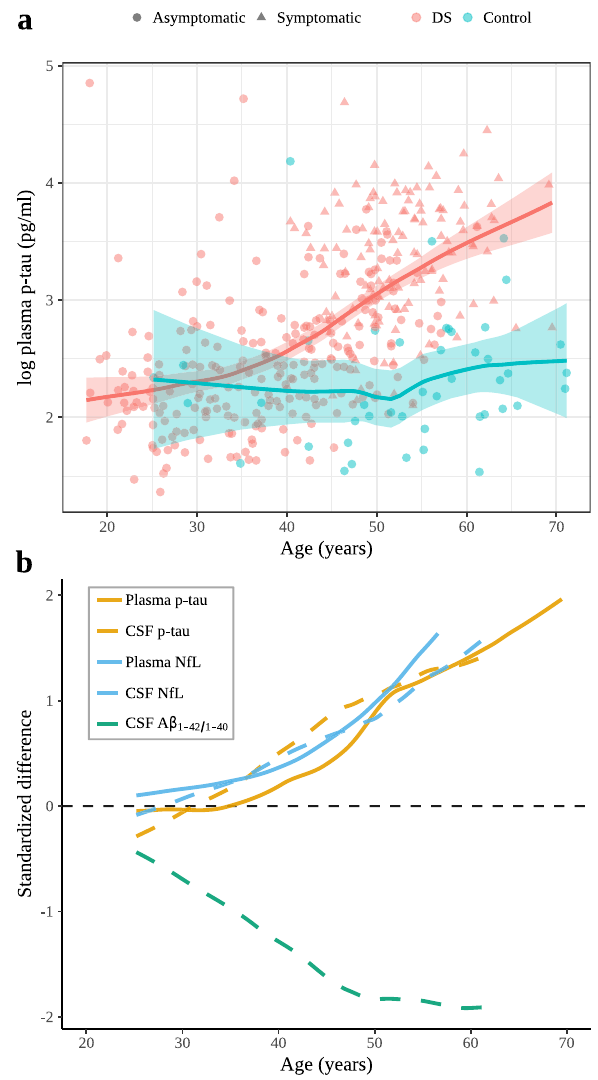
Fig. 1 Changes with age in plasma p-tau181 concentrations in Down syndrome and euploid controls. a Age-related changes in p-tau181 levels in individuals with Down syndrome (asymptomatic, prodromal Alzheimer ’ s disease and Alzheimer ’ s disease dementia, all in red) and in euploid controls (blue). The central lines indicate the fi tted linear model for each group and the shadowed ribbons show the 95% con fi dence level intervals. b Integrated model of the natural history of Alzheimer ’ disease in Down syndrome. Comparison of the evolution of the standardized differences between participants with Down syndrome and controls fi tted with a locally estimated scatterplot smoothing curve. Plasma p-tau levels are represented in a solid red line and are compared with CSF p-tau levels and both plasma and CSF NfL levels (modi fi ed from ref. 4 ). Positive standardized differences represent higher biomarker values in participants with Down syndrome compared to euploid controls and negative values represent lower biomarker values. Standardized differences were computed by the difference between the DS and the controls divided by the standard deviation of both